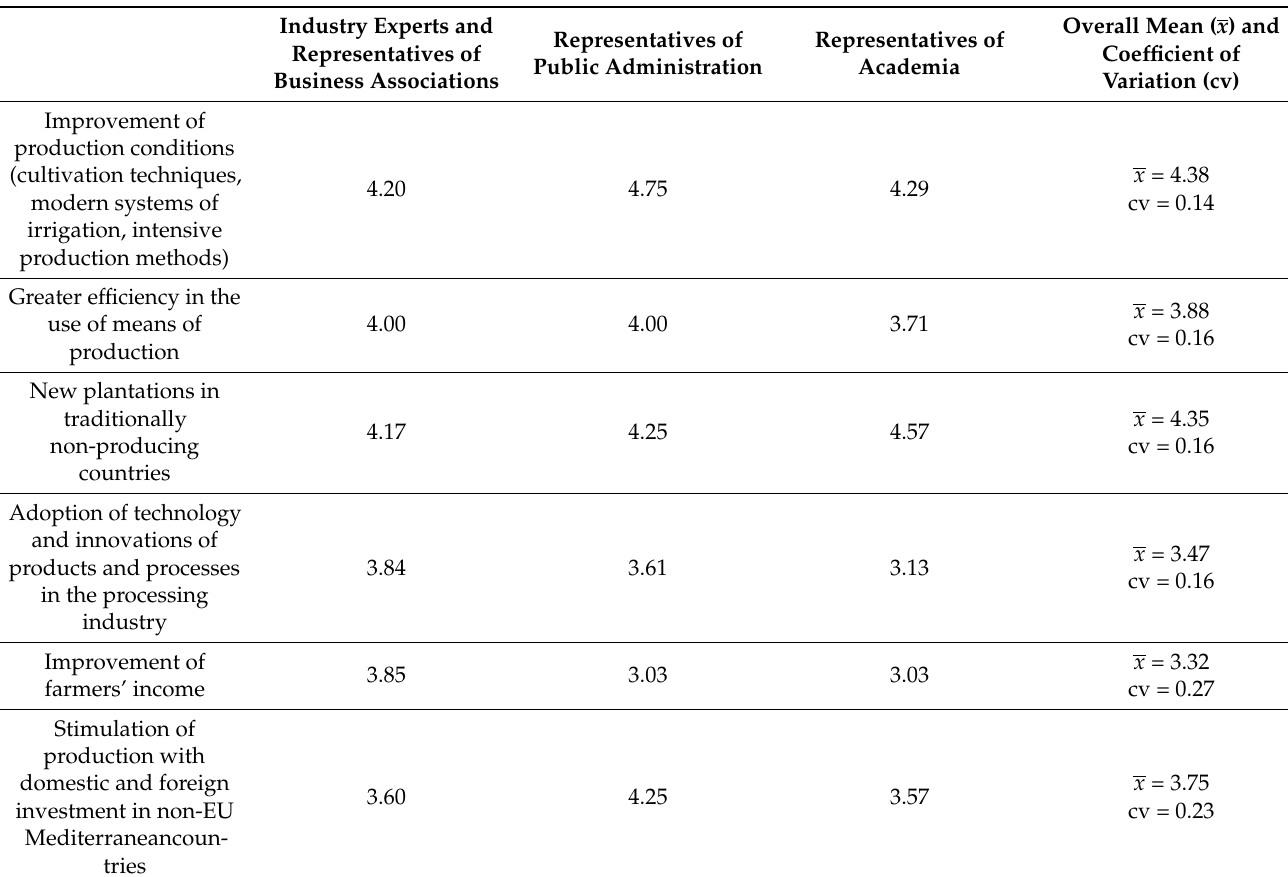
Table 3. Conditioning factors of the future increase in the global olive oil